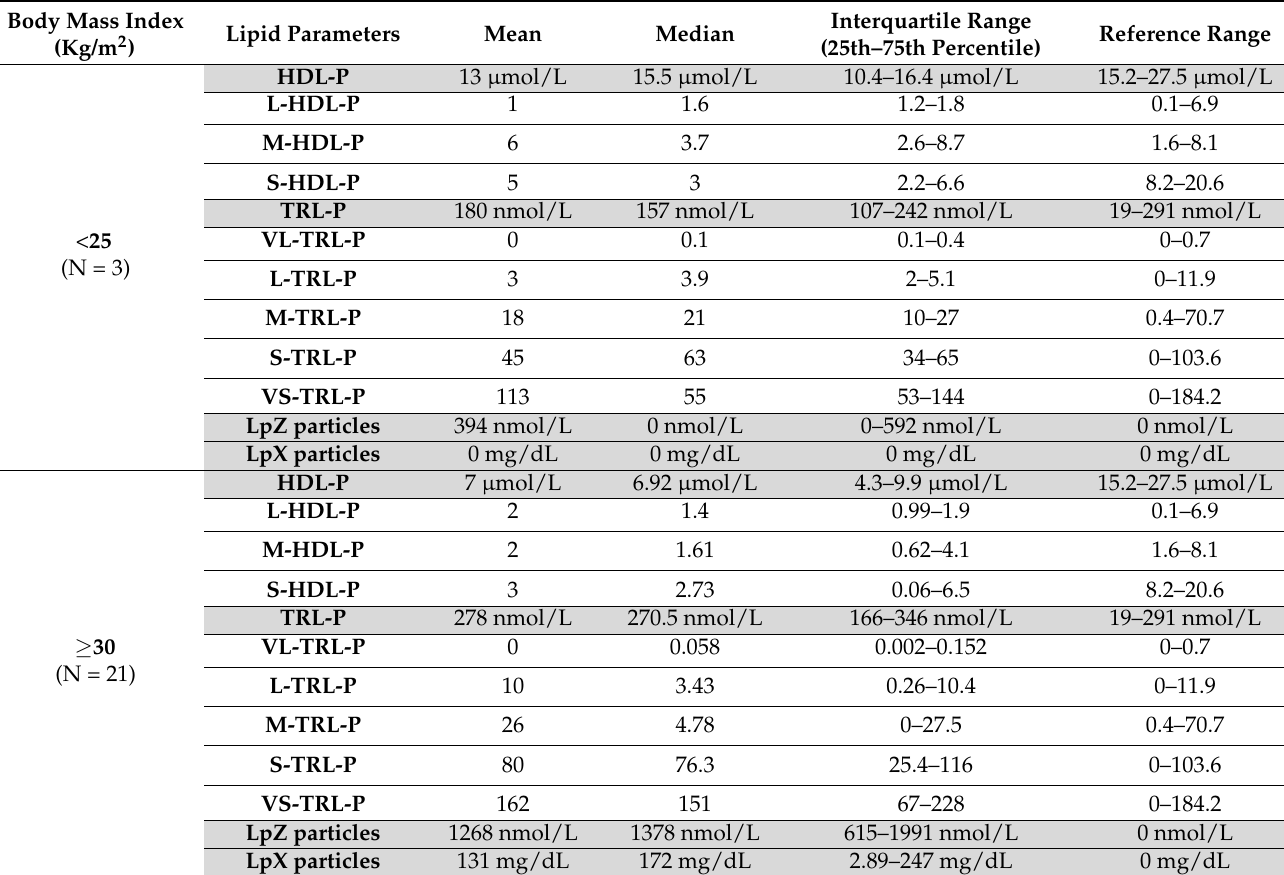
Table 3. The distribution of HDL, TRL, LpX and LpZ particles by BMI of the